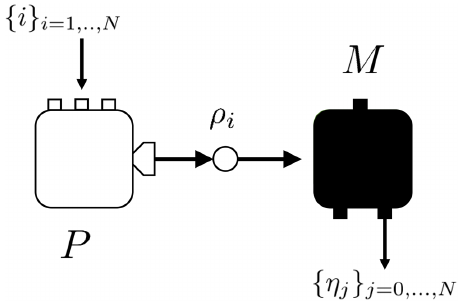
FIG. 6. The prepared quantum states are well characterized (white). Detectors are arranged to find which state has been sent. The certification of maximum confidence on a measurement can be obtained from outcome rates from untrusted detectors